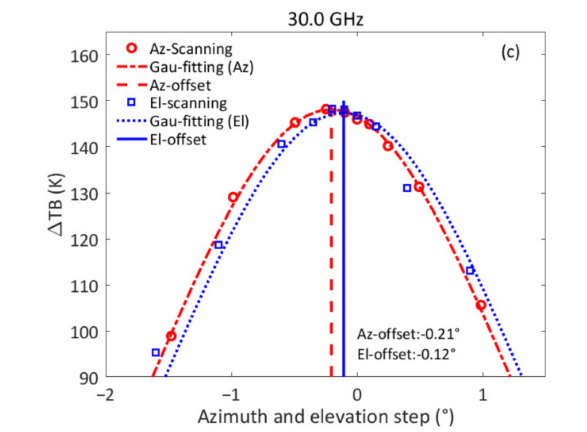
Figure 11. The real solar scanning and calibrating examples at 22.235, 26.235, and 30.0 GHz and the Gaussian fitting curve using the least-square method. The “Az” and “El” mean the antenna azimuth and elevation, respectively. The “Gau-fitting” means the Gaussian fitting curve using the least-square method. “Offset” means the offset angle of the antenna pointing. The horizontal axis is the rotation angle of the GMR antenna for the azimuth and elevation and the origin represents the center of the sun. The vertical axis is the TB increment. ( a )22.35 GHz, ( b ) 26.235 GHz, and ( c ) 30.0